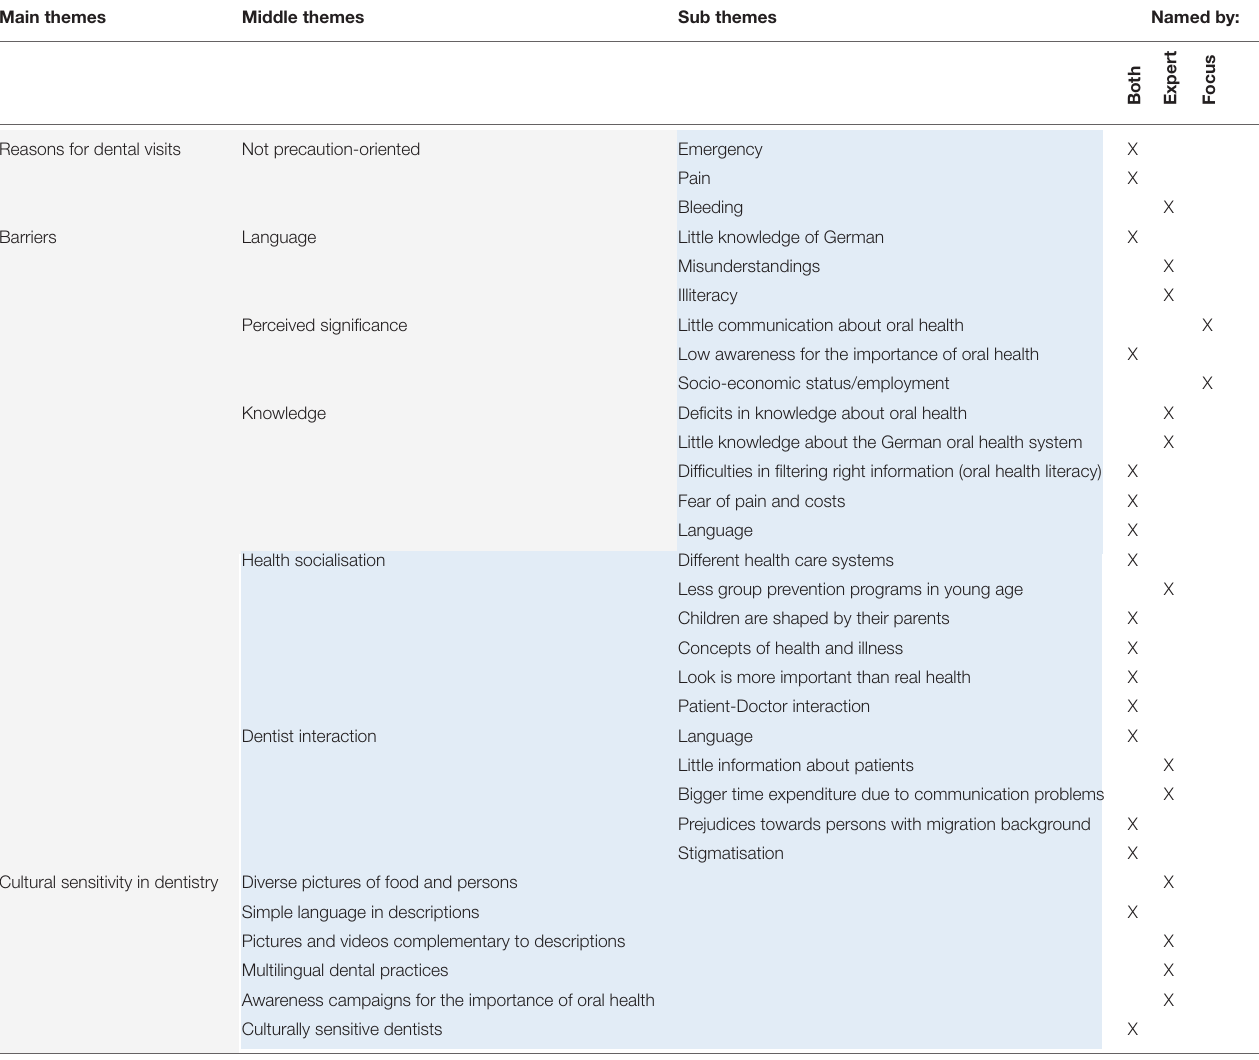
TABLE 3 | Theme system: main, middle and sub themes. Main